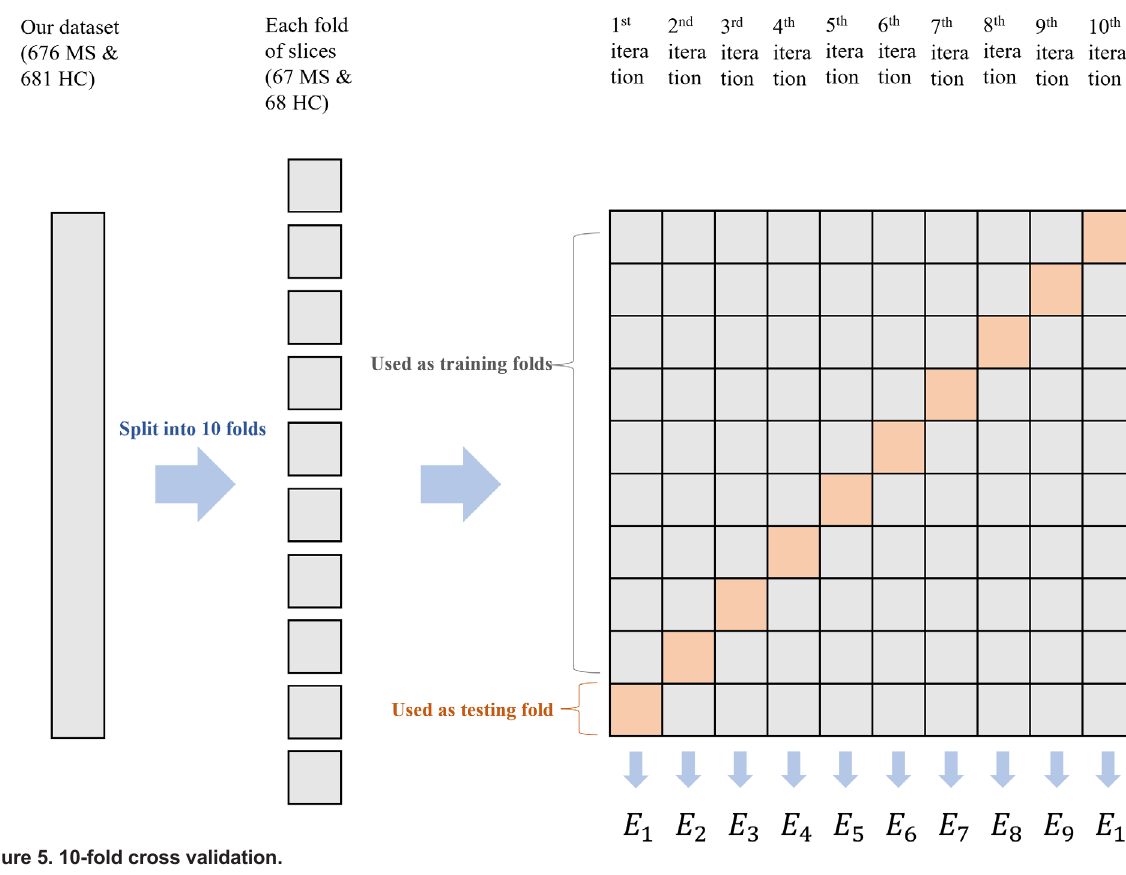
Figure 5. 10-fold cross